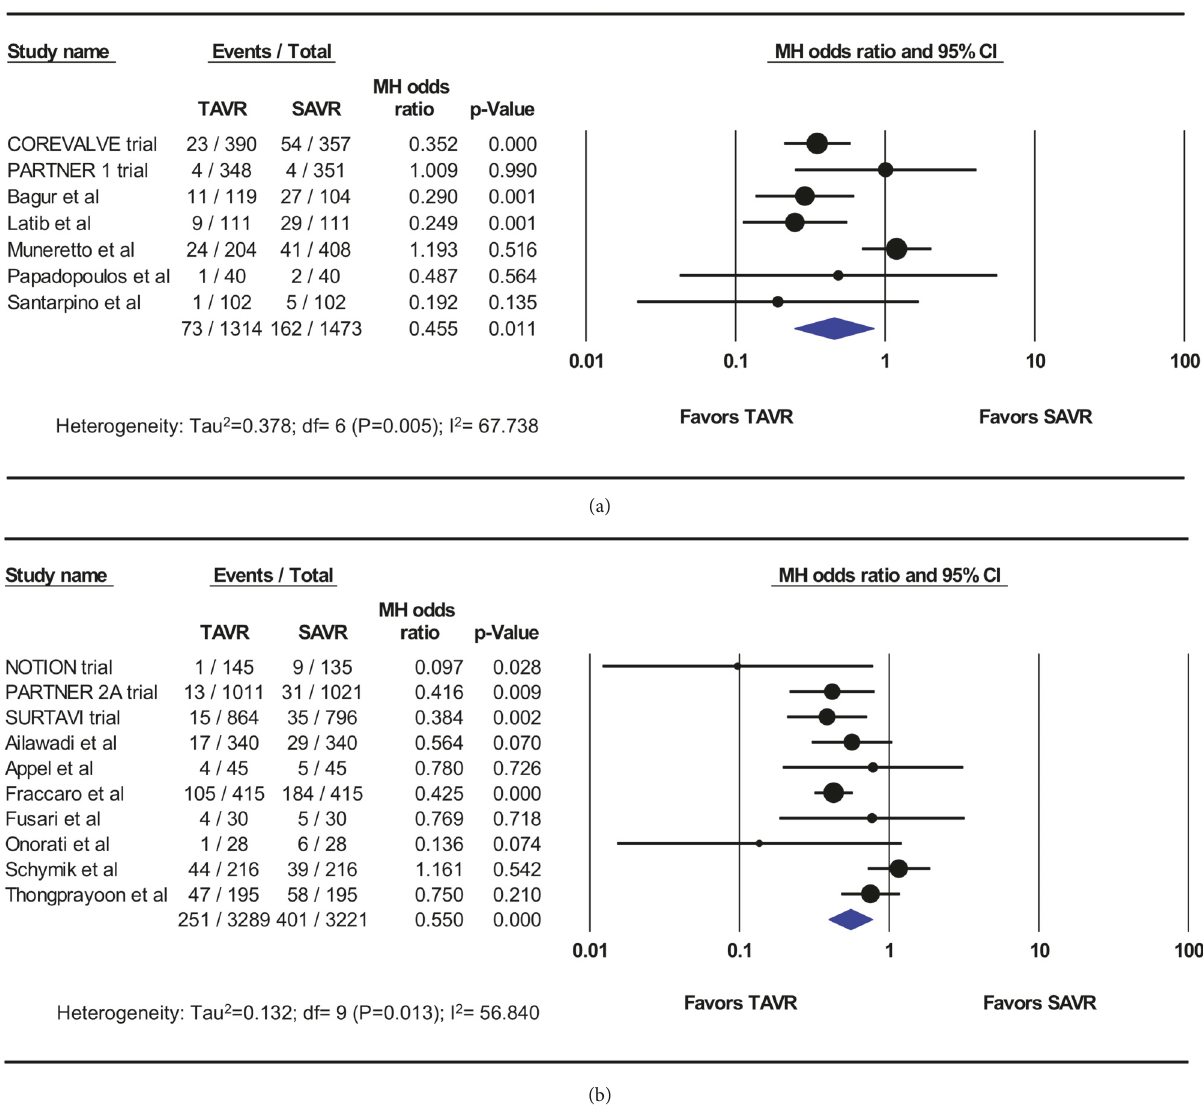
Figure5:Pooledeffectestimatesfor30-dayacutekidneyinjuryaccordingtothetypeofaorticvalvereplacementprocedureintherandomized controlled trials. TAVR: transcatheter aortic valve replacement, SAVR: surgical aortic valve